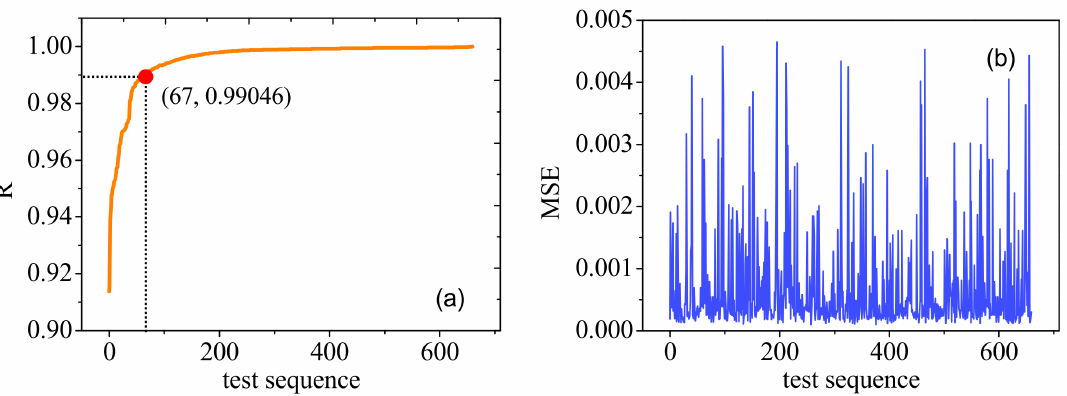
Figure 7. Results for the prediction of drain transient current pulse: ( a ) shows the goodness of fit of the test set, and ( b ) shows the MSE value of the test set.